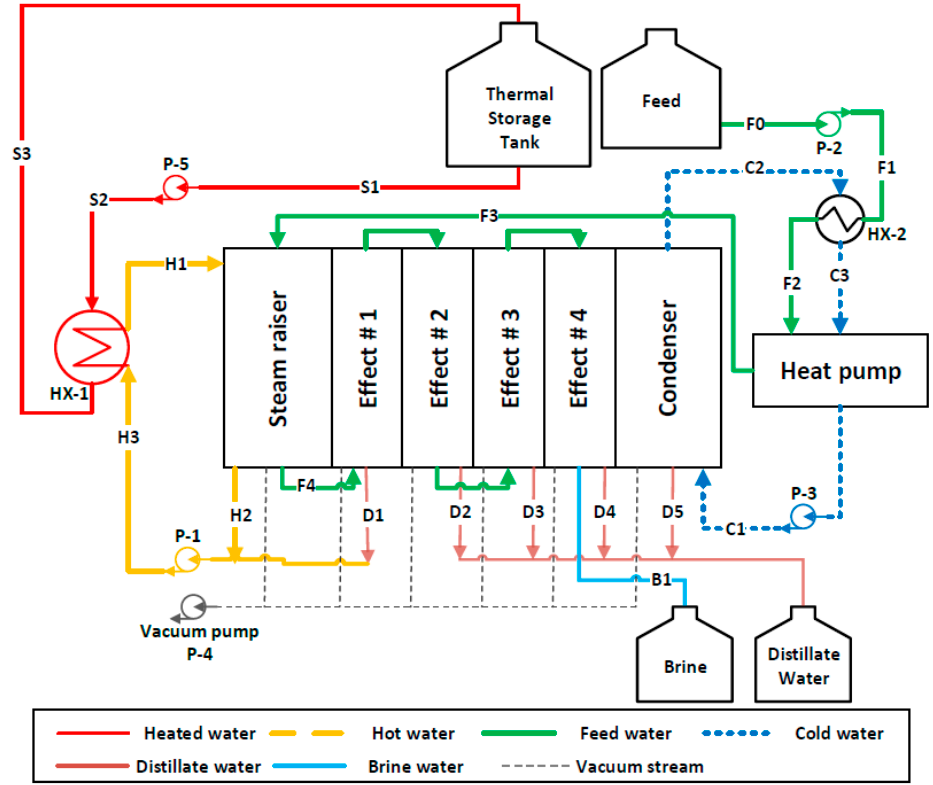
Figure 3. V-MEMD system under forward-flow configuration.